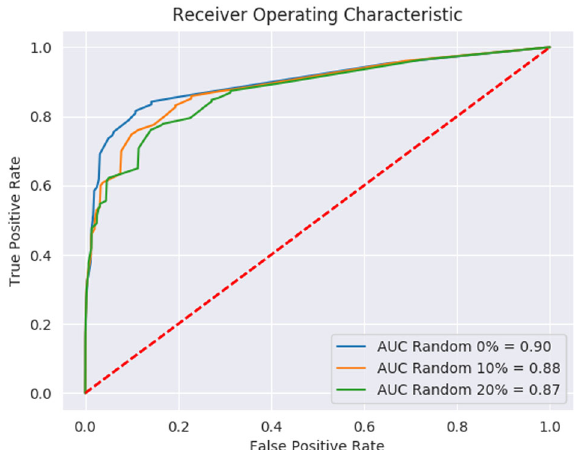
Fig. 4 Performance on stimulated test sets. ROC curves showing the performance of the model on stimulated test sets, in which we randomly selected negative reports for all fi ve symptoms at a time and substituted them with blank values. The ROC curve for the original test set is shown in blue. The orange and green curves are ROC curves for randomly substituting 10% and 20%, respec- tively, of the negative values for all fi ve